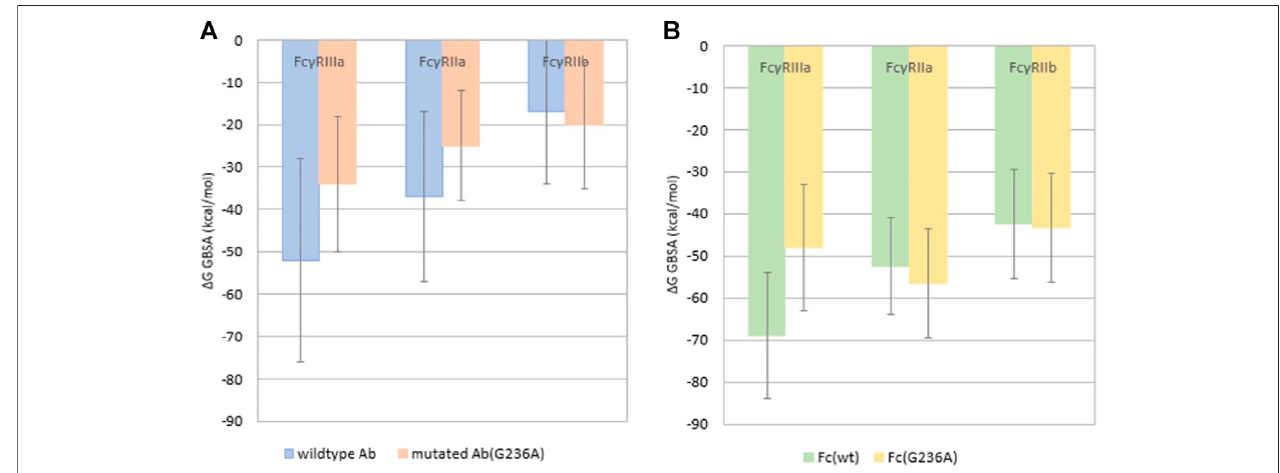
FIGURE 5 | Binding free energy calculated using the MM/GBMV method for the complex of (A) the complete antibody with Fc γ Rs and (B) the isolated Fc region with Fc γ Rs. The error bars represent standard deviations.